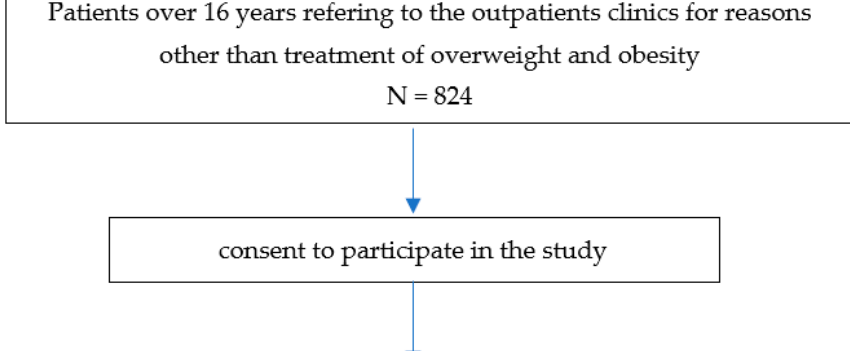
Figure 1. Study recruitment flow chart.